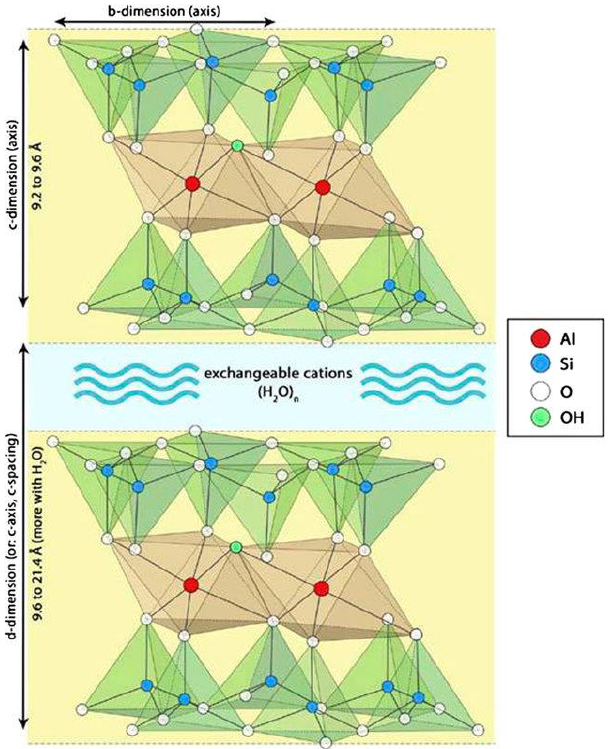
Figure 2. Montmorillonite unit [69]. The triple layers are principally extended along the b-axis, whereas the unit is repeated several times along the c-axis. This creates plate-shaped